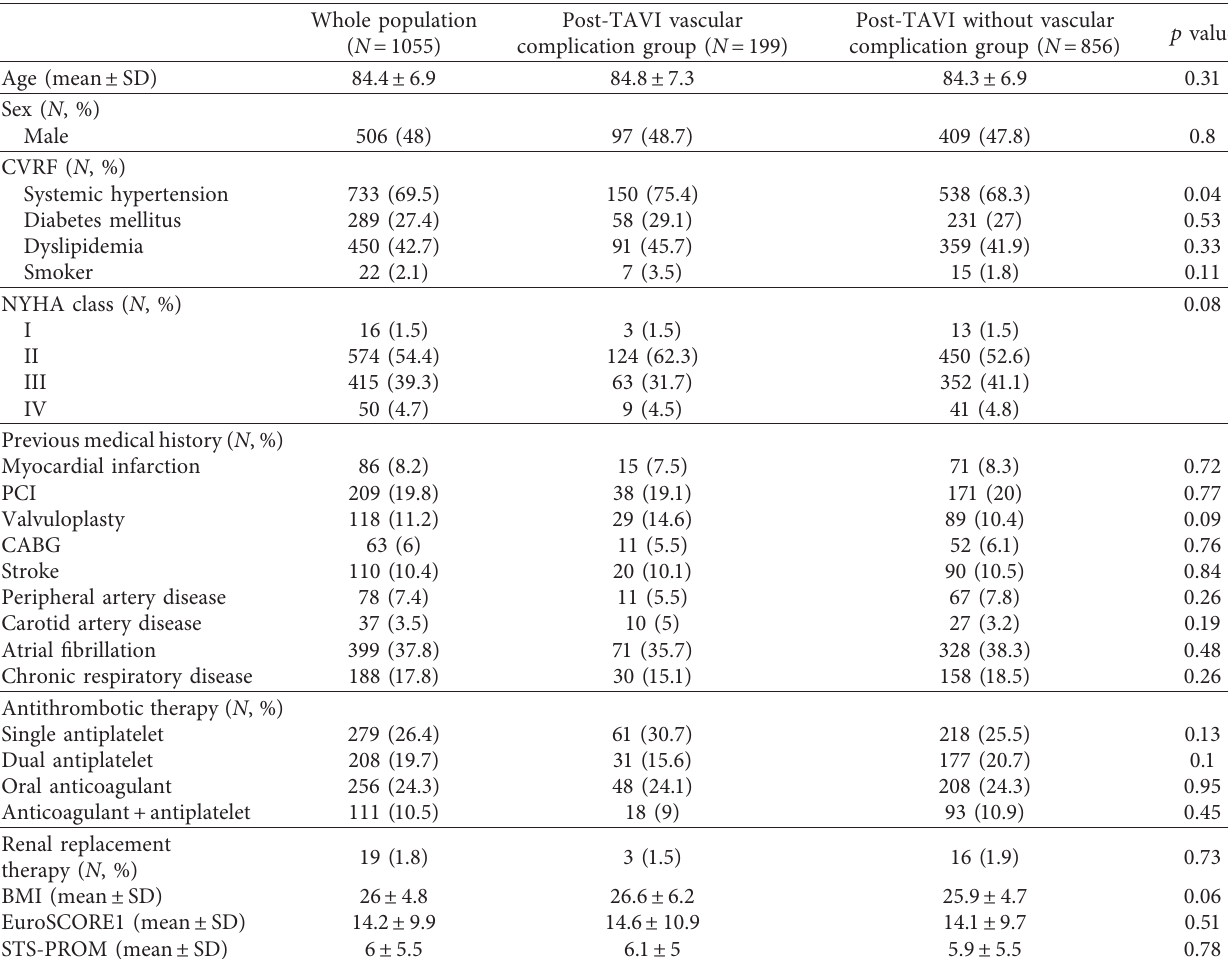
Table 1: Baseline characteristics of the studied population.